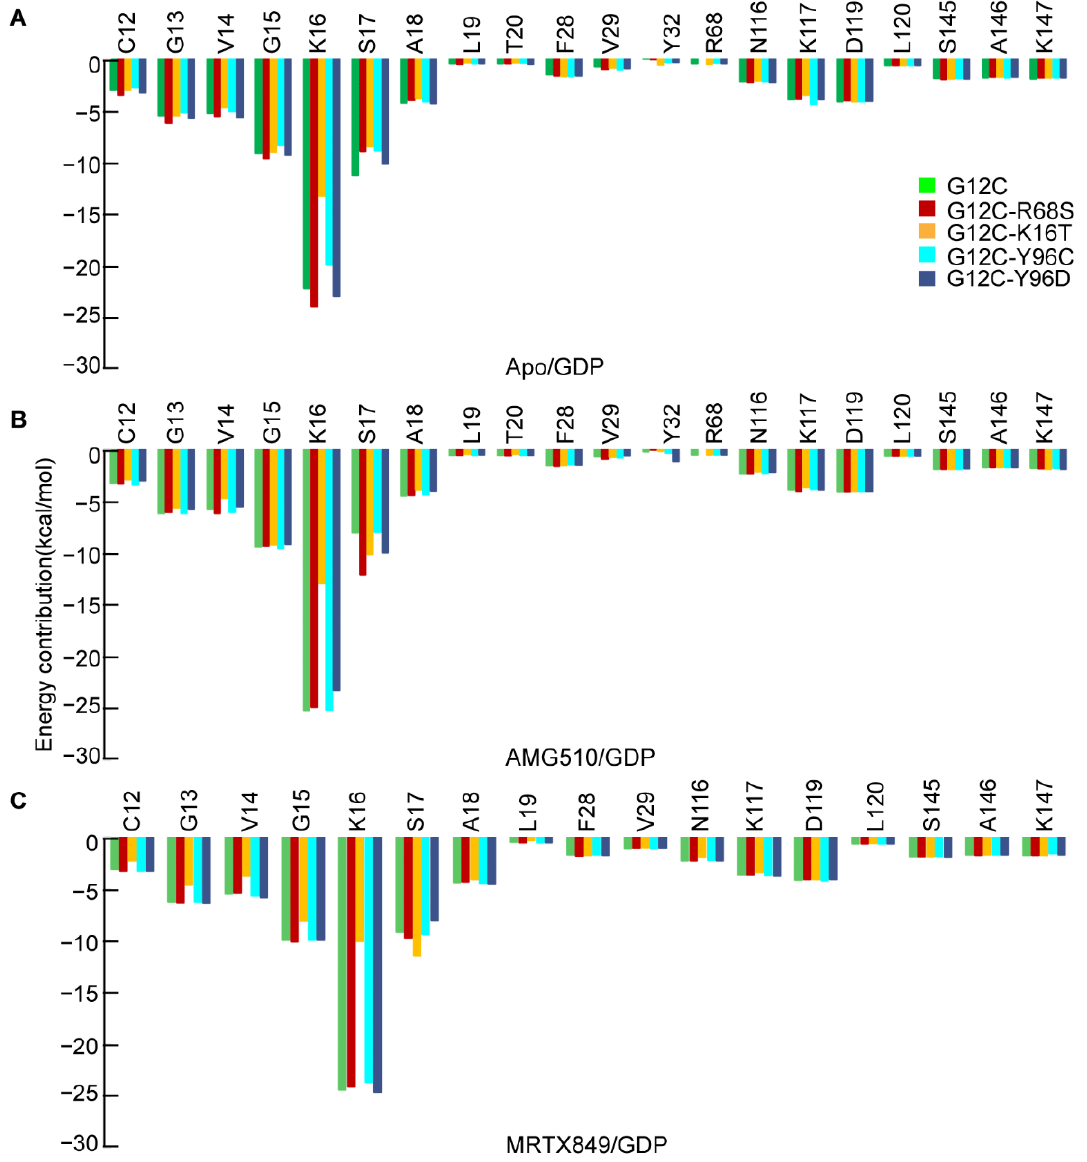
Figure 4. Per-residue energy profiles for GDP binding in apo ( A ), AMG510 ( B ) and MRTX849 ( C ) inhibitor bound to mutated KRAS G12C, G12C-K16T, G12C-R68S, G12C-Y96C and G12C-Y96D, re- spectively.